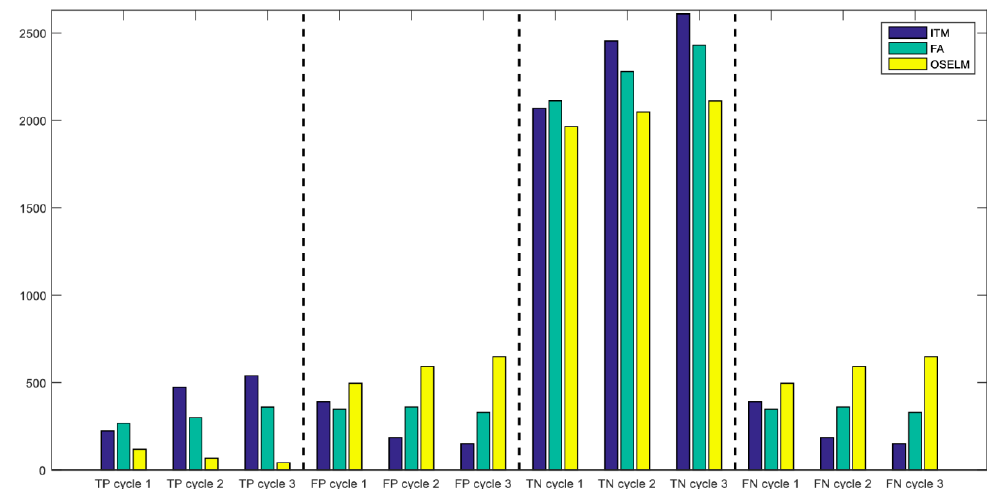
Figure 12. Classification measures with respect to cycles for the three models with the KDD99 dataset.